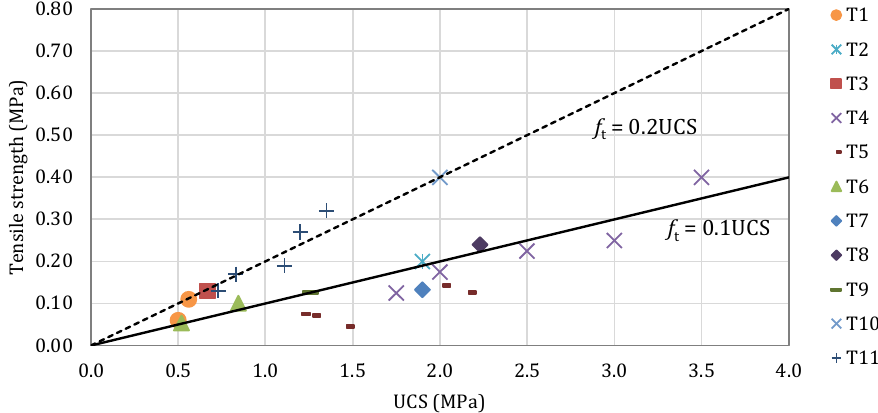
Figure 5. The relationship between UCS and tensile strength: T1 [2], T2 [21], T3 [25], T4 [49], T5 [52],